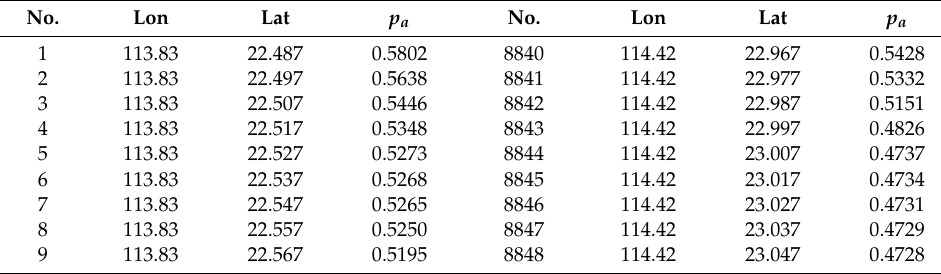
Table 5. Partial damage probability results of pre-correction.